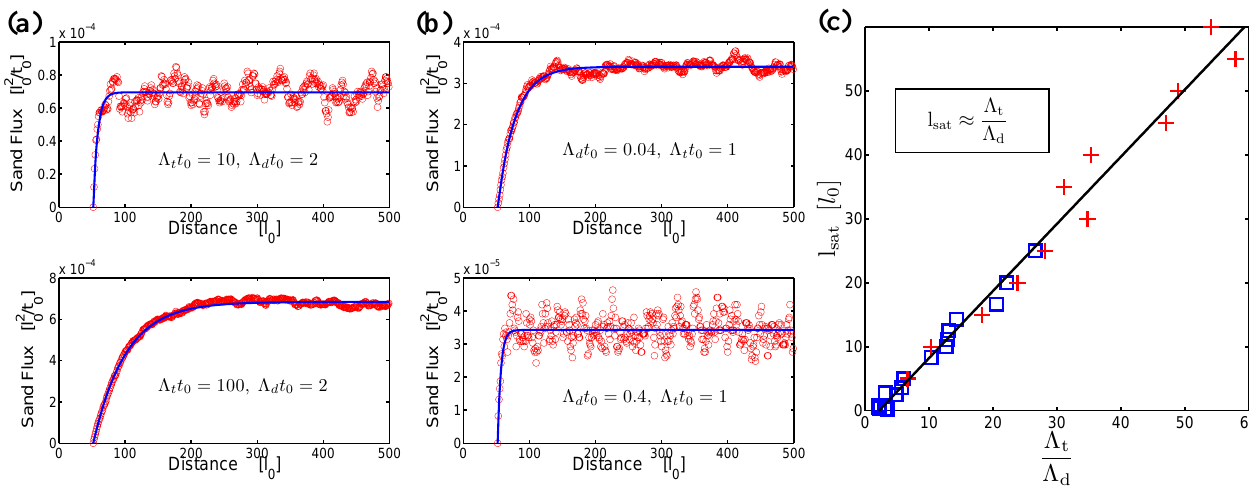
Fig. 5. Relation between l sat and the rate parameters of the cellular automaton model. (a) Increase of the saturation length with respect to an increasing 3 t -value for 3 d t 0 = 2. (b) Decrease of the saturation length with respect to an increasing 3 d -value for 3 t t 0 = 0 . 4. (c) l sat with respect to 3 t /3 d , the mean distance traveled by a mobile sedimentary cell: 3 d t 0 = 2 (blue squares), 3 t t 0 = 0 . 4 (red crosses).